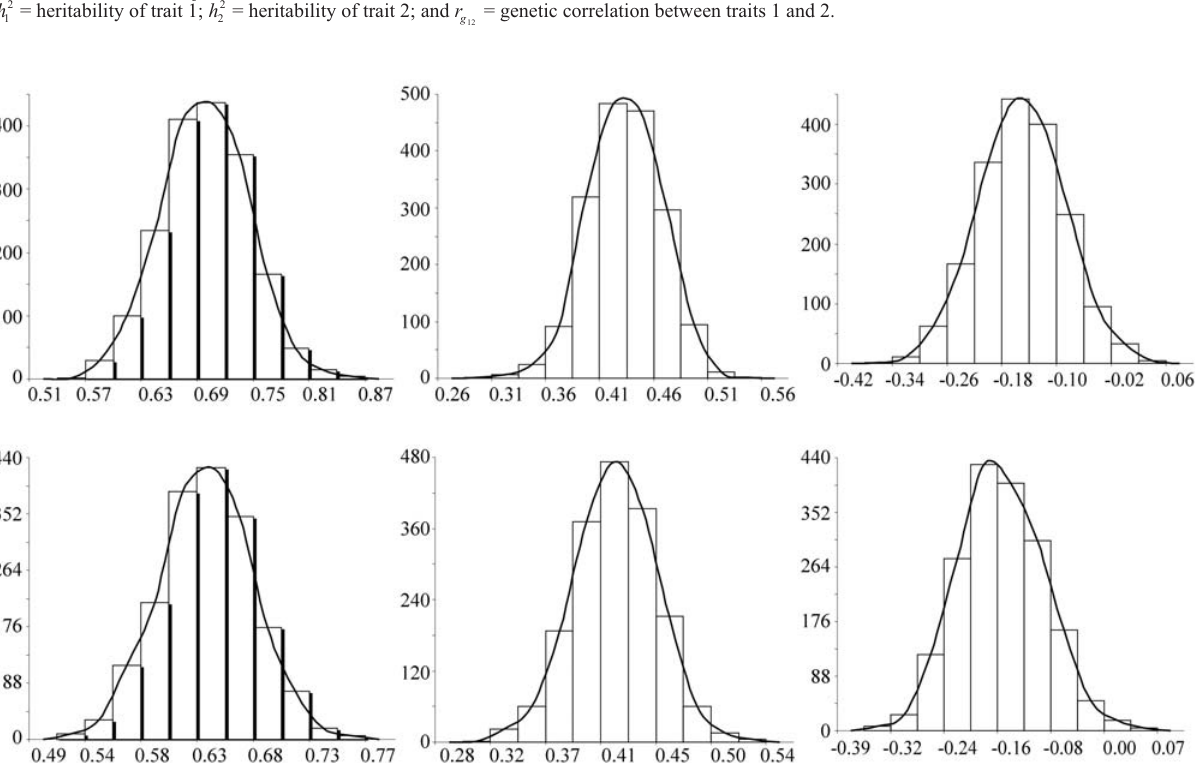
Figure 2 - Posterior densities estimates of genetic parameters for scrotal circumference at 365 days of age (1) and (2) age at first calving (upper) and scrotal circumference at 450 days of age (1) and (2) age at first calving (lower) from two-trait analyses using Gibbs